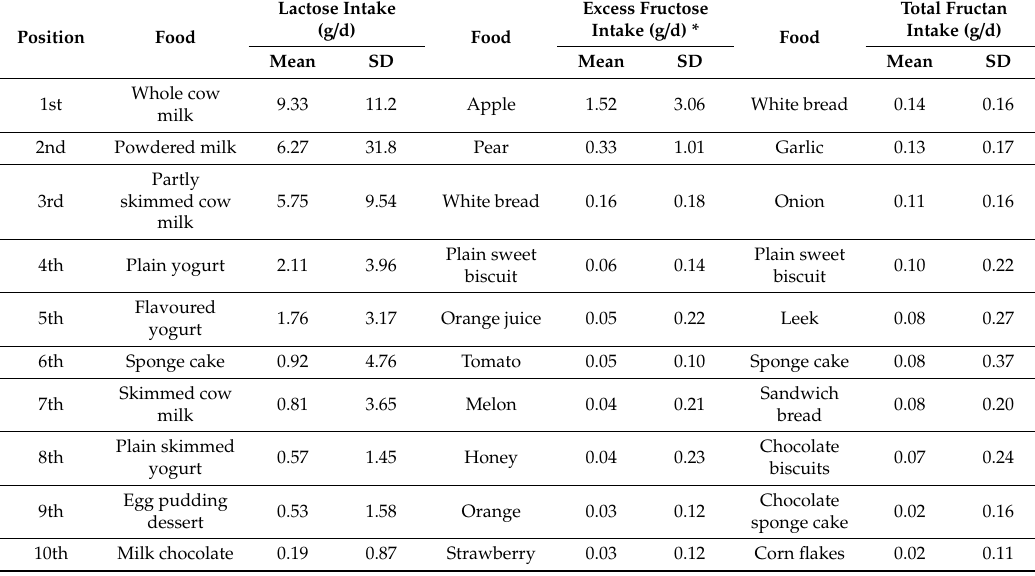
Table 2. Top ten foods representing the higher intake source of lactose, excess fructose and total fructan in Spanish diet of children population aged between 3 and 9 years old.